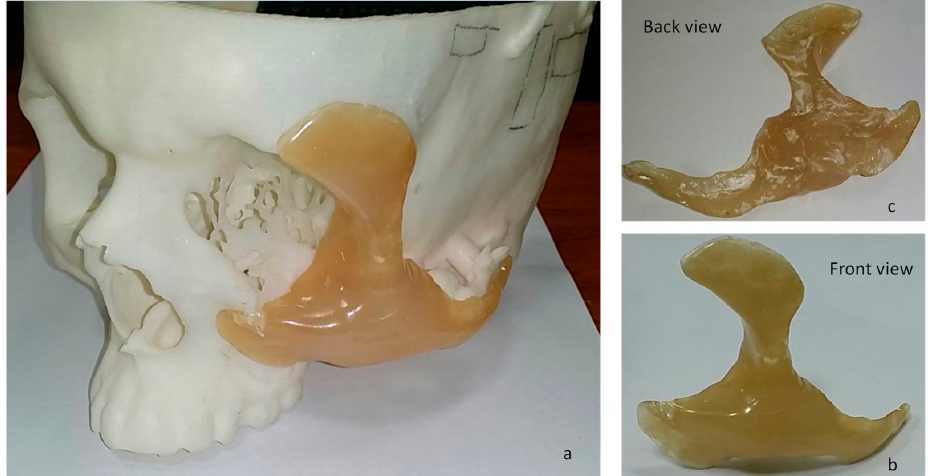
Figure 3. ( a ) Fused deposition Modeling fabricated skull model with the attached silicone implant; ( b ) silicone implant front view; and ( c ) silicone implant back view.